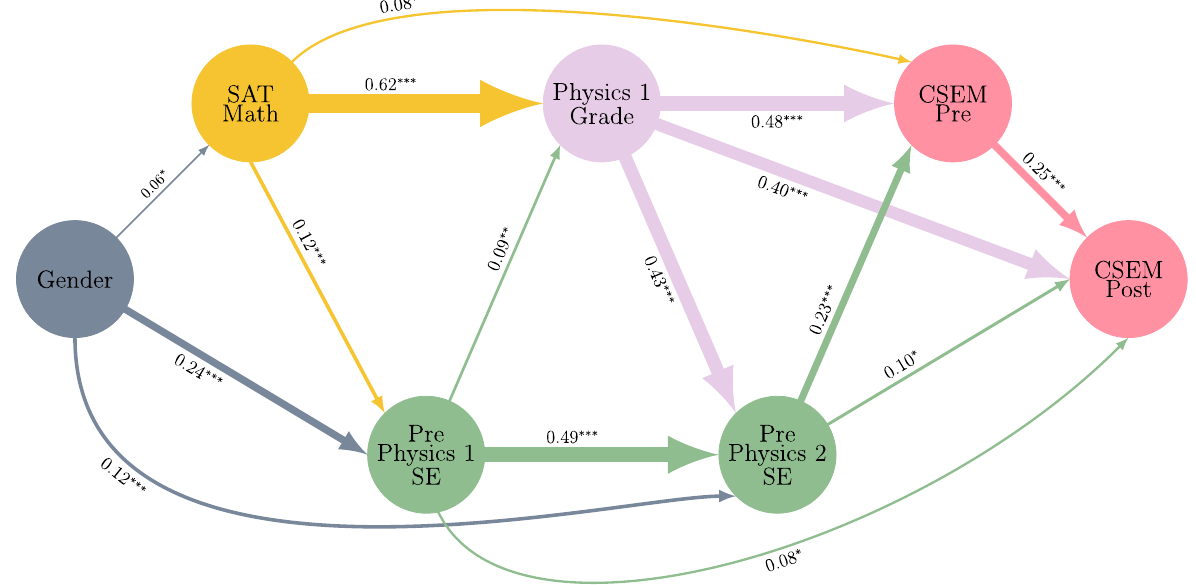
Fig. 2. Results of the structural equation modeling between gender and standardized post-test score (CSEM post) through pre self- efficacy in Physics 1 and 2, SAT math, Physics 1 grade and the CSEM prescore. The line thicknesses correspond to the magnitude of β values. All p values are indicated by *** for p < 0 . 001 and ** for p < 0 . 01 . Each arrow with the line connecting two variables in the diagram indicates the direction of